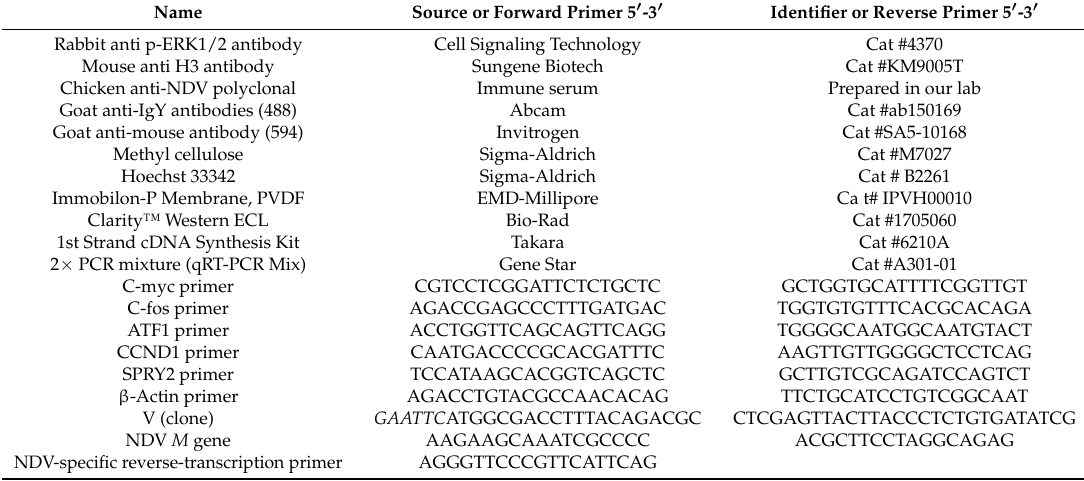
Table 1. Reagents and primer